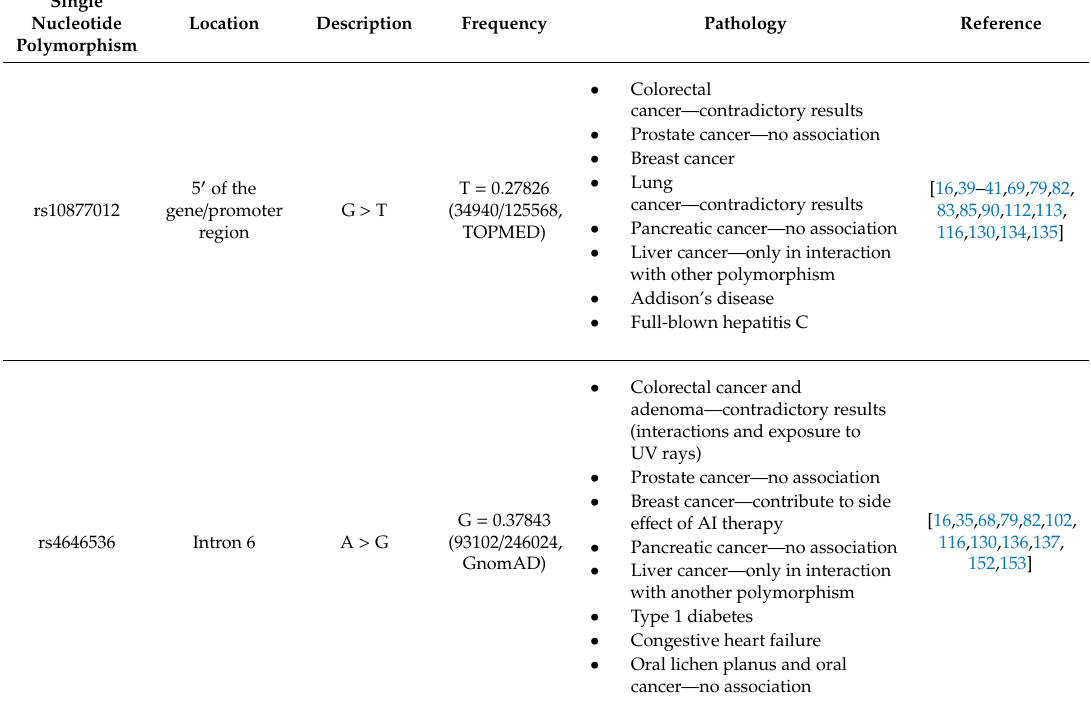
Table 1. CYP27B1 gene polymorphisms (SNPs) and their roles in disease